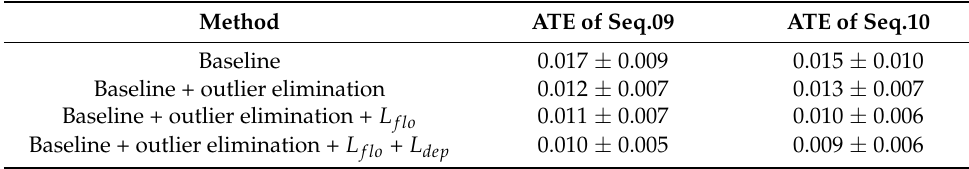
Table 1. Comparison of ATE of different versions of the framework on KITTI odometry. L flo and L dep indicate optical flow consistency loss and depth consistency loss, respectively.